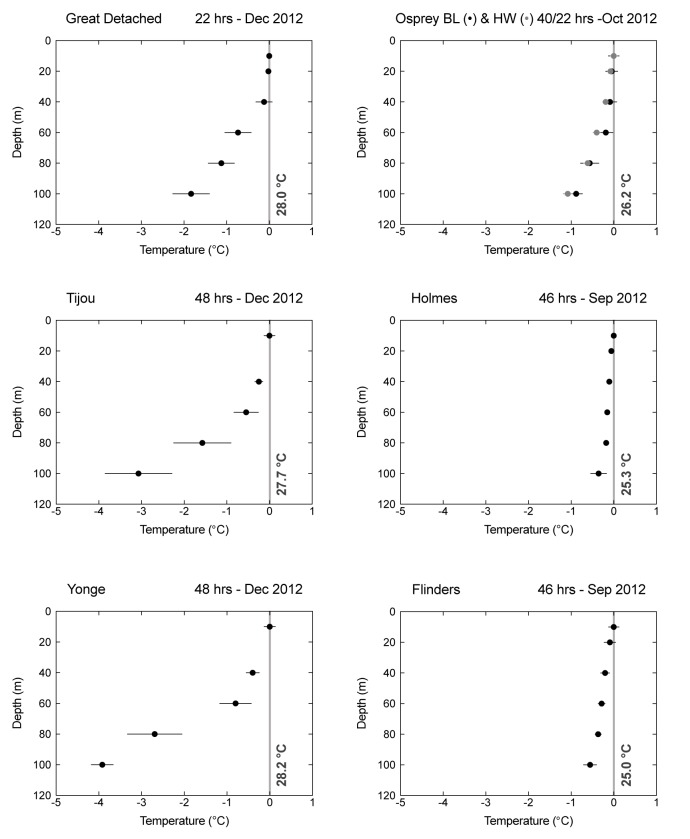
Short-term temperatures over a 10–100 m depth range for 7 of the study sites.Average temperatures (°C ± SD—indicated with arrow bars) at 10, 20, 40, 60, 80 and 100 m depth expressed relative to 10 m mean temperatures. Note the different measurement durations (22–48 hrs) and different months in which the temperature data was collected.